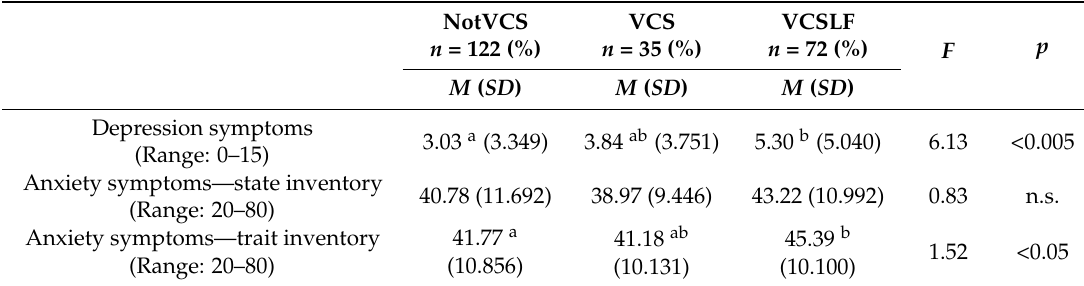
Table 3. Depression and anxiety symptoms: comparison between subjects who had not experienced cyberstalking (NotVCS), victims of cyberstalking (VCS) and victims who had experienced cyberstalking and previous offline victimization in their lifetimes (VCSLF) (one-way ANOVA) ( N = 229).